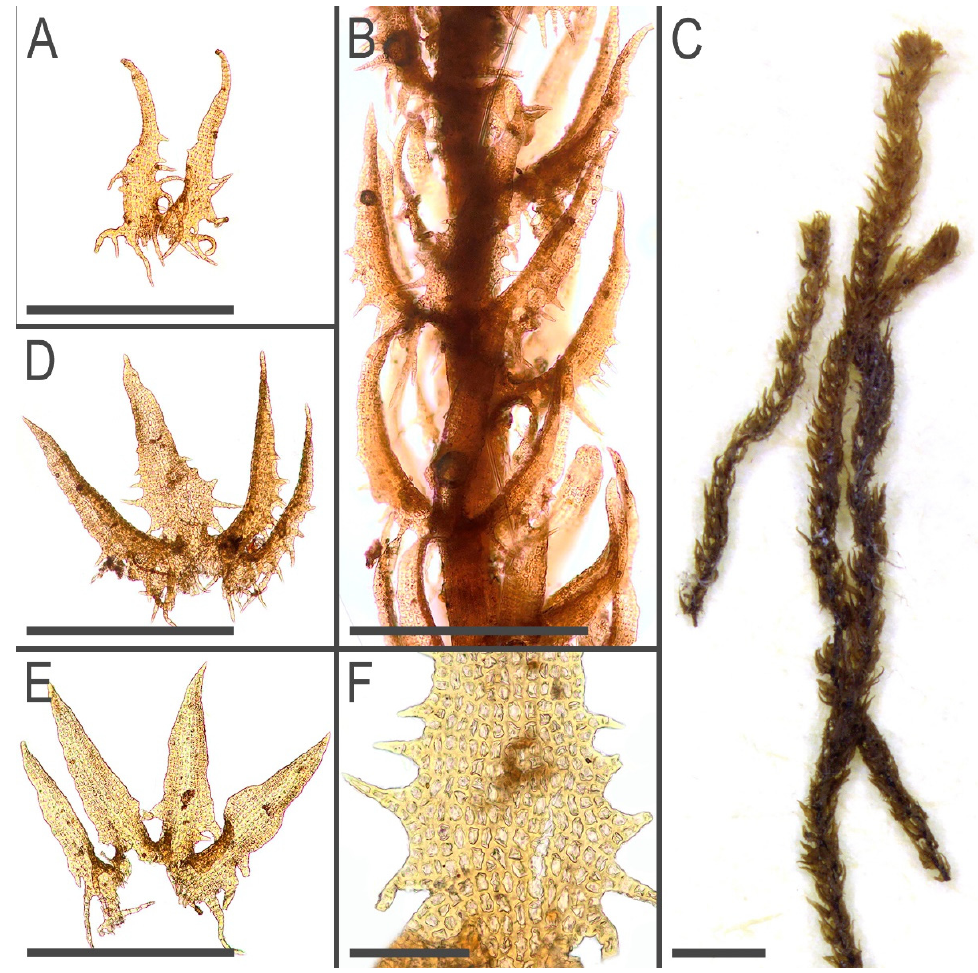
Figure 10. Tetralophozia filiformis (Steph.) Urmi: A —underleaf; B —plant habit, fragment, lateral view; C —plant habit; D , E —leaves; F —cells in leaf lobe base. Scales: A , B , D , E —500 µm; F —100 µm; C —1 mm. All from G00112121.